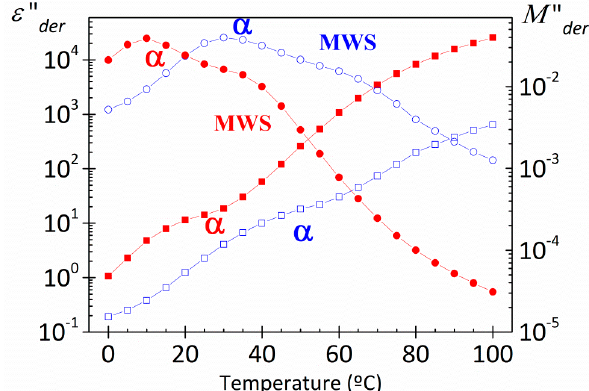
Figure 7. Temperature dependence of the loss permittivity (square) and loss modulus (circle) derivative spectra of the PAzMA1 (open symbols) and PAzMA2 (full symbols) at 1.19 × 10 0 Hz. spectra of the PAzMA1 (open symbols) and PAzMA2 (full symbols) at 1.19 × 10 0